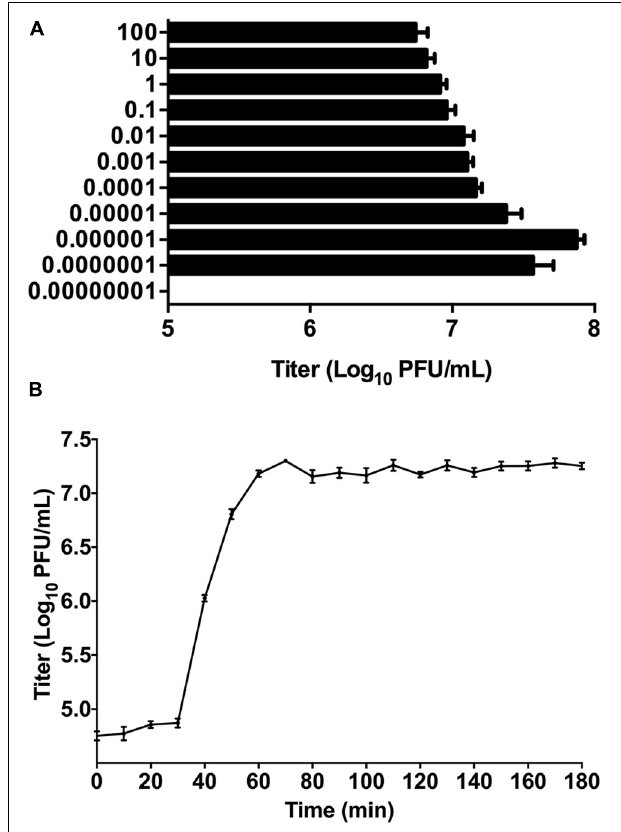
FIGURE 2 | The growth characteristics of P-KP2. (A) Titers of the phage under different MOI (phage/bacteria = 0.00000001, 0.0000001, 0.000001, 0.00001, 0.0001, 0.001, 0.01, 0.1, 1, 10, and 100), as indicated in the Y-axis. At the MOI of 0.000001, P-KP2 reached maximum titers. (B) One-step growth curve of P-KP2 was carried out at MOI = 0.1. Each data is shown as means ± SEM from three biological